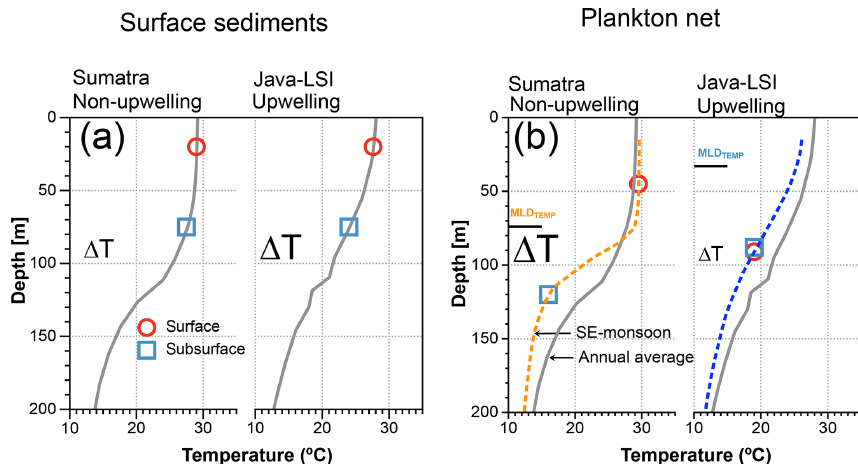
Figure 10. Schematic comparing the (cid:49)T derived from mixed-layer and thermocline dwellers off Sumatra and Java–LSI, from (a) surface sediment (inferred habitat depth from Mohtadi et al., 2011) matching the mean annual conditions and (b) ALD from plankton net matching the water column structure during the sampling period (SE monsoon, August–September 2005). Gray lines depict the average annual mean water column structure offshore Sumatra and Java–LSI (band of 160km wide, > 200 stations from WOA2018, 0.25 ◦ ) (Locarnini et al., 2018); dashed lines depict the average water column structure in each sector during the SE monsoon based on in situ data collected during the PABESIA cruise (August–September 2005); the black line shows the average depth of the MLD TEMP (Table